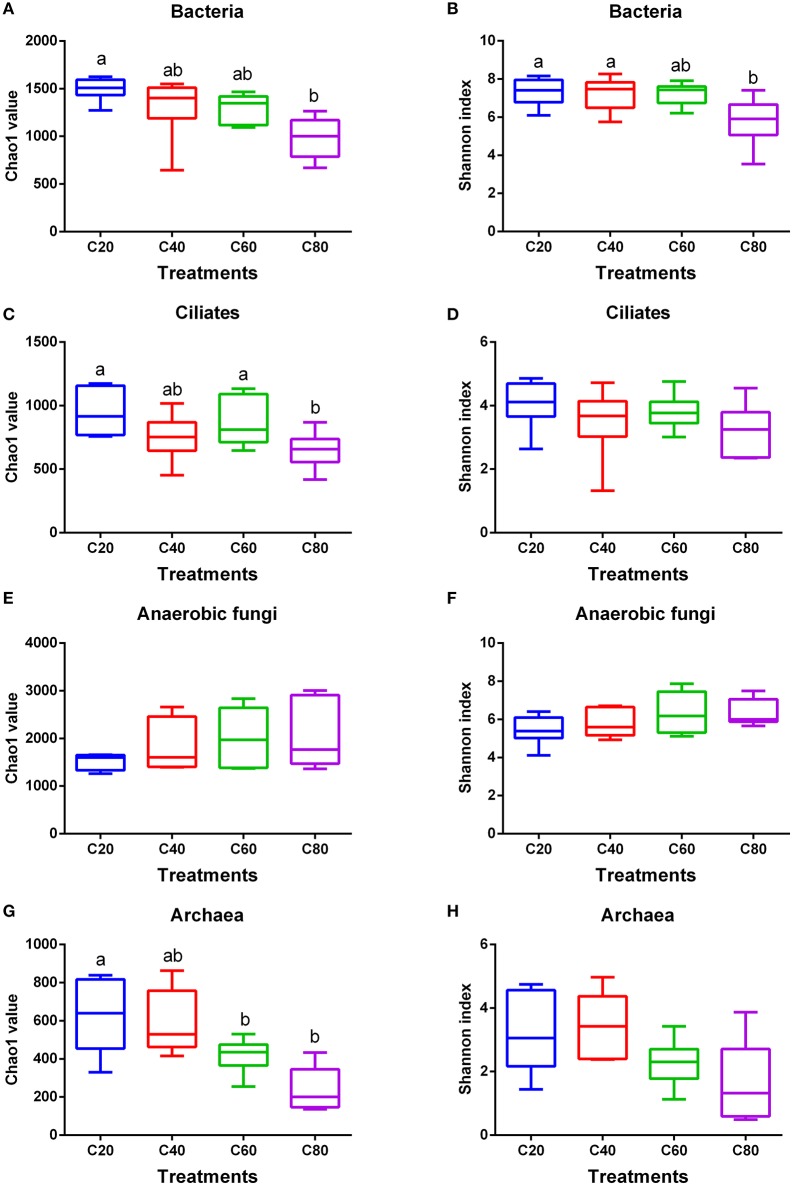
Changes in ruminal microbial richness and diversity with increasing levels of concentrate in diets. Bacterial (A), ciliate protozoal (C), anaerobic fungal (E), and archaeal (G) richness estimated by the Chao1 value. Bacterial (B), ciliate protozoal (D), anaerobic fungal (F), and archaeal (H) diversity estimated by Shannon index. Boxes represent the interquartile range (IQR) between the first and third quartiles (25 and 75th percentiles, respectively), and the horizontal line inside the box defines the median. Whiskers represent the lowest and highest values within 1.5 times the IQR from the first and third quartiles, respectively. Boxes with the different letters above their whiskers are significantly different (P < 0.05) among treatments. C20, diet containing 20% of concentrate; C40, diet containing 40% of concentrate; C60, diet containing 60% of concentrate; C80, diet containing 80% of concentrate.